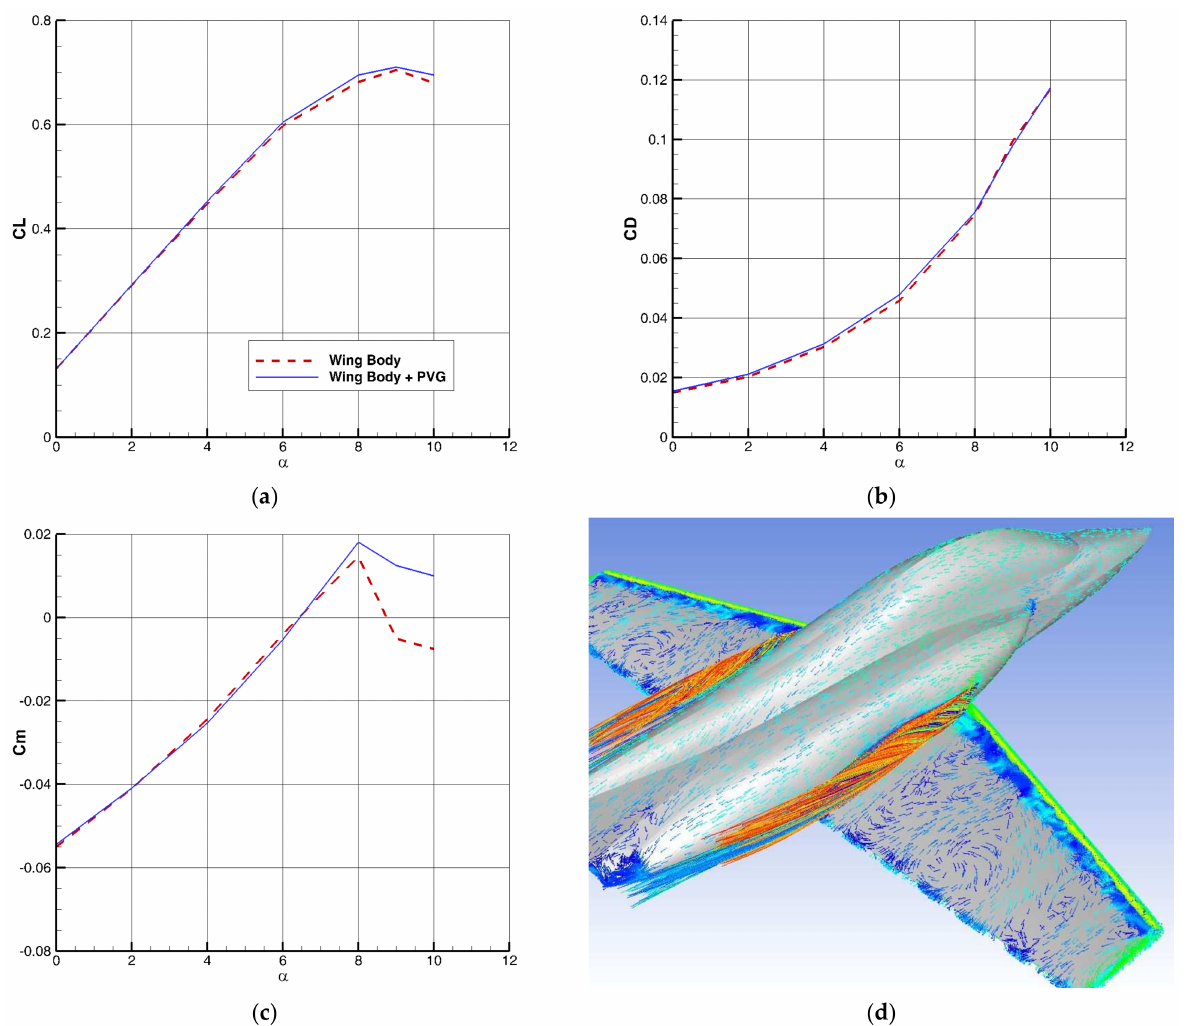
Figure 11. Effect of PVG on the clean configuration of the wing-body in M = 0.6, h = 18,000 ft: ( a ) C L − α diagram; ( b ) C D − α diagram; ( c ) C m − α diagram; ( d ) the path lines of PVG and wing- body vectors at α = 9 ◦